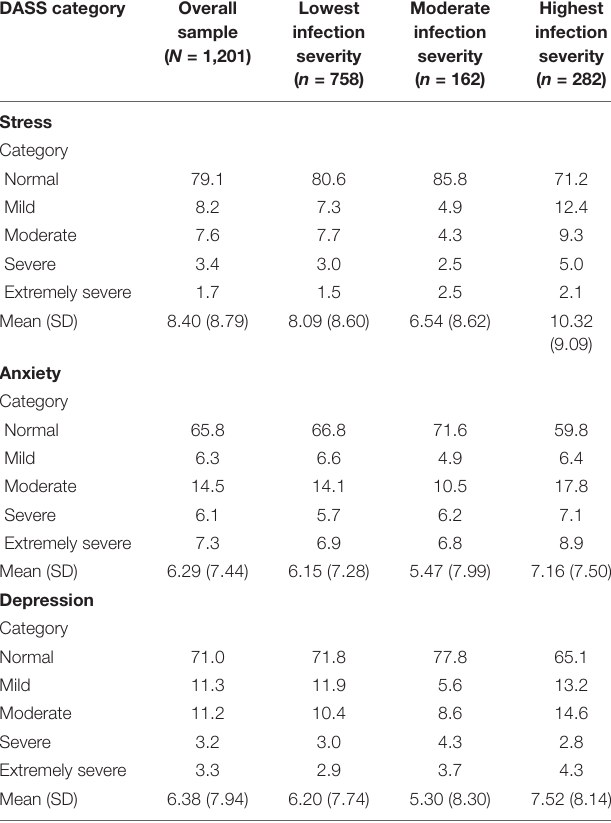
TABLE 4 | Percentage of participants falling into each DASS category and means (standard deviations) for the overall sample and infection severity in region of residence.